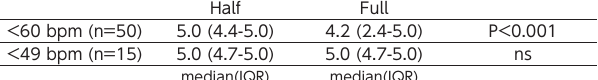
Relation between the mean evaluation points of the evaluators and the heart rate for each reconstruction algorithm. For half-reconstruction images, the extent of artifacts was low for all subjects. For full-reconstruction images, however, the extent of motion artifacts tended to increase as the heart rate increased. Table 3. Comparison of evaluation points between reconstruction algorithms according to the heart